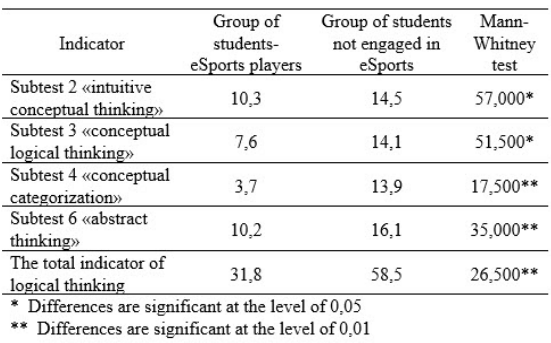
Table 1. Results of diagnostics of the level of development of logical thinking of eSports students and students who are not en- gaged in eSports